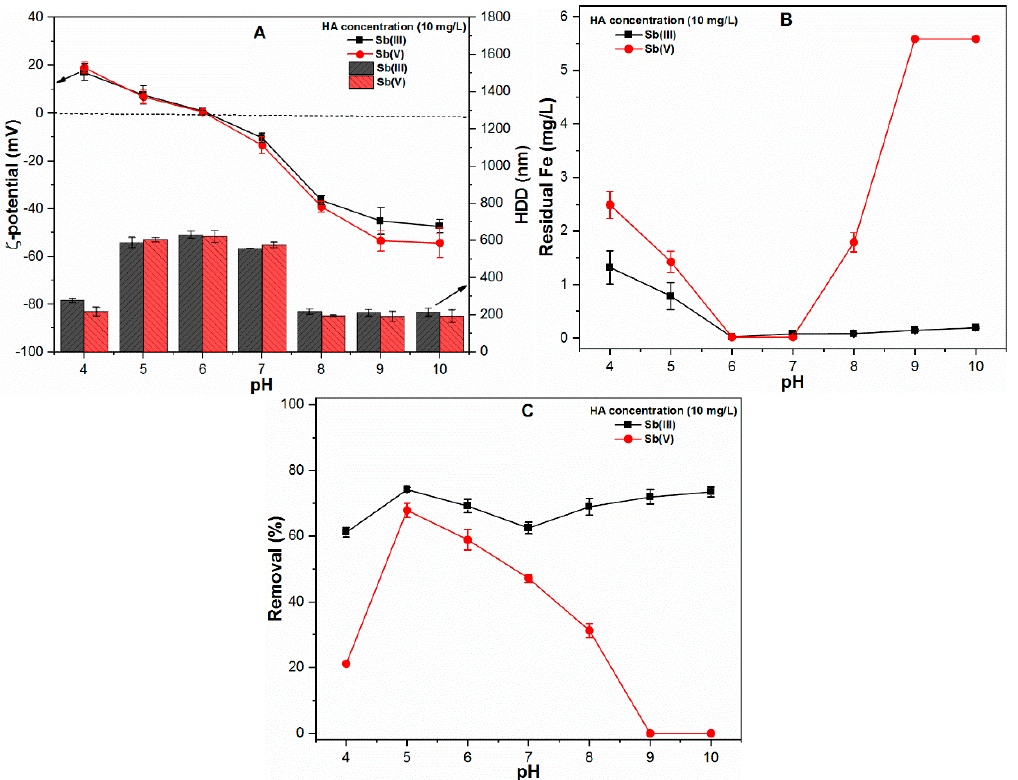
Figure 5. At various pH ranges (4–10), FC dose (0.1 mM), temperature (25 ± 1 °C), HA concentration (10 mg / L) and Sb(III, V) concentration (1 mg / L) showing ( A ) ζ -potential (mV) and HDD of precipitates (10 mg/L) and Sb(III, V) concentration (1 mg/L) showing ( A ) ζ -potential (mV) and HDD of precipitates (nm); ( B ) Residual Fe (mg / L) and; ( C ) Removal (%) of both Sb (nm); ( B ) Residual Fe (mg/L) and; ( C ) Removal (%) of both Sb species.